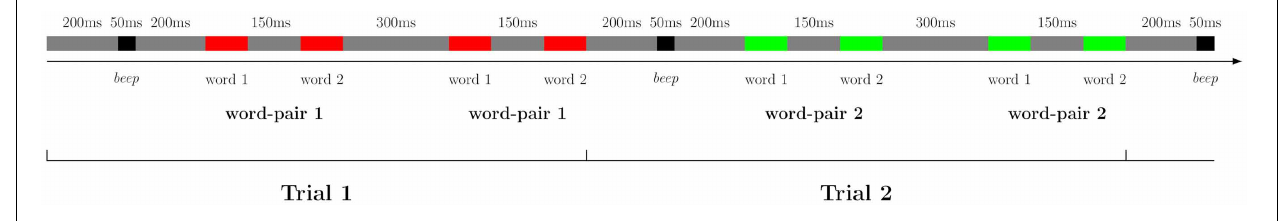
FIGURE 4 | Aural presentation of word pairs in the study phases of Experiments 3 and